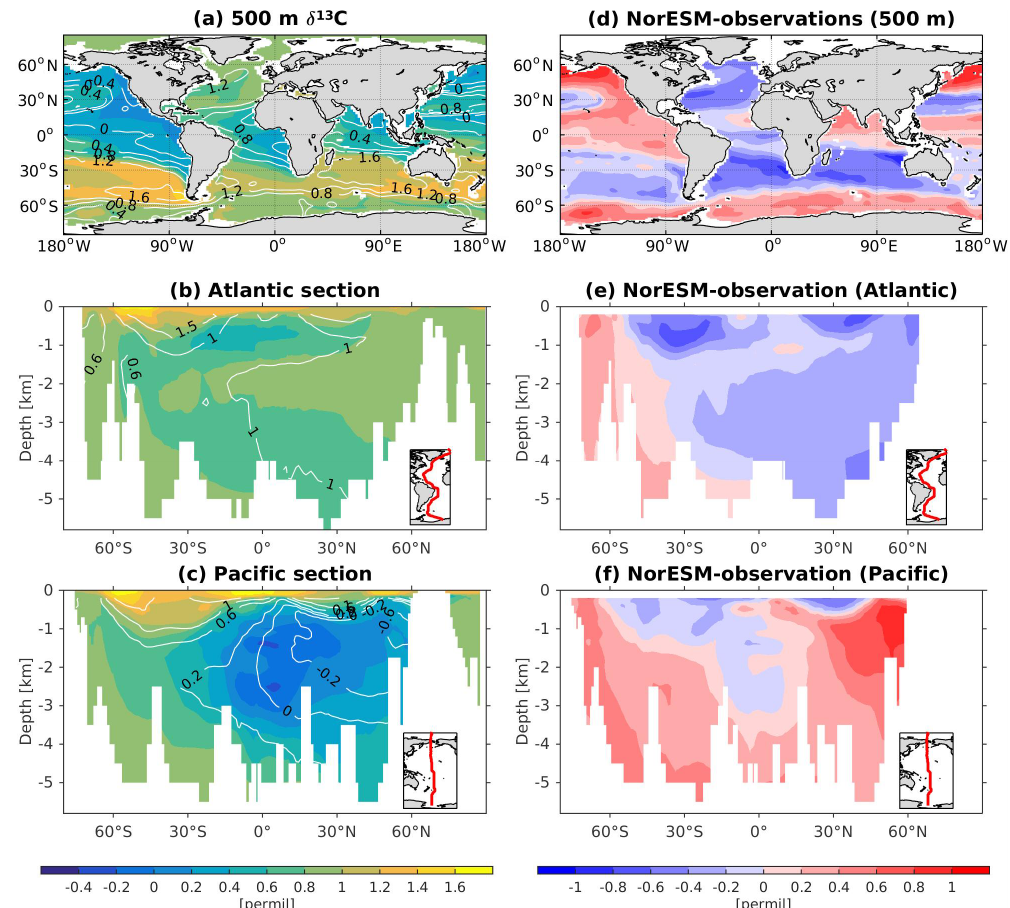
Figure 21. Climatological δ 13 C values at (a) 500m of depth and across the vertical sections of (b) the Atlantic and (c) Pacific from NorESM2- OC (colour shadings) and observations (contour lines). Differences between NorESM2-OC and observations are shown as colour shadings in panels (d) – (f)